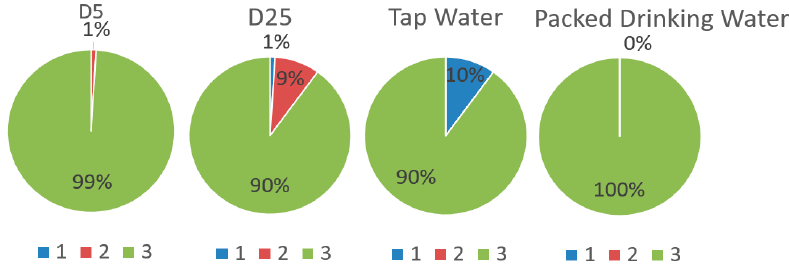
Figure 14. Percentage use of LED pairs with different fluid used.